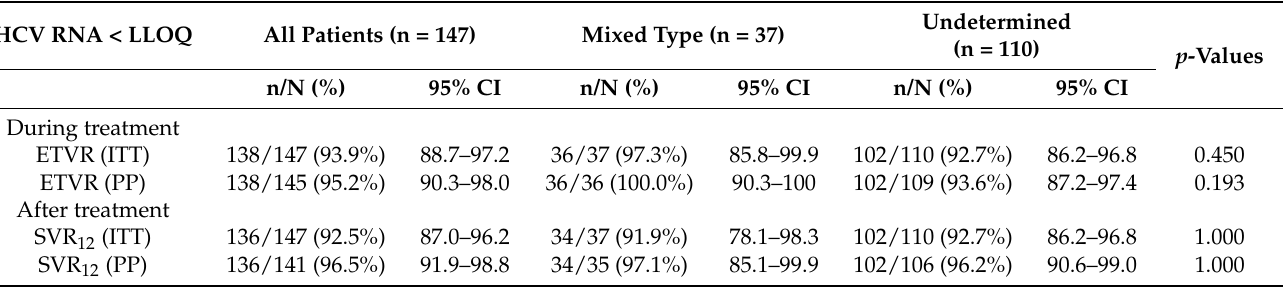
Table 3. Treatment response of the study population.